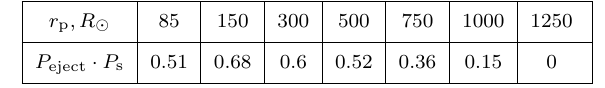
Table 3. Survival probability for a star released from the neighborhood of a super- massive black hole with a velocity satisfying the criterion of an